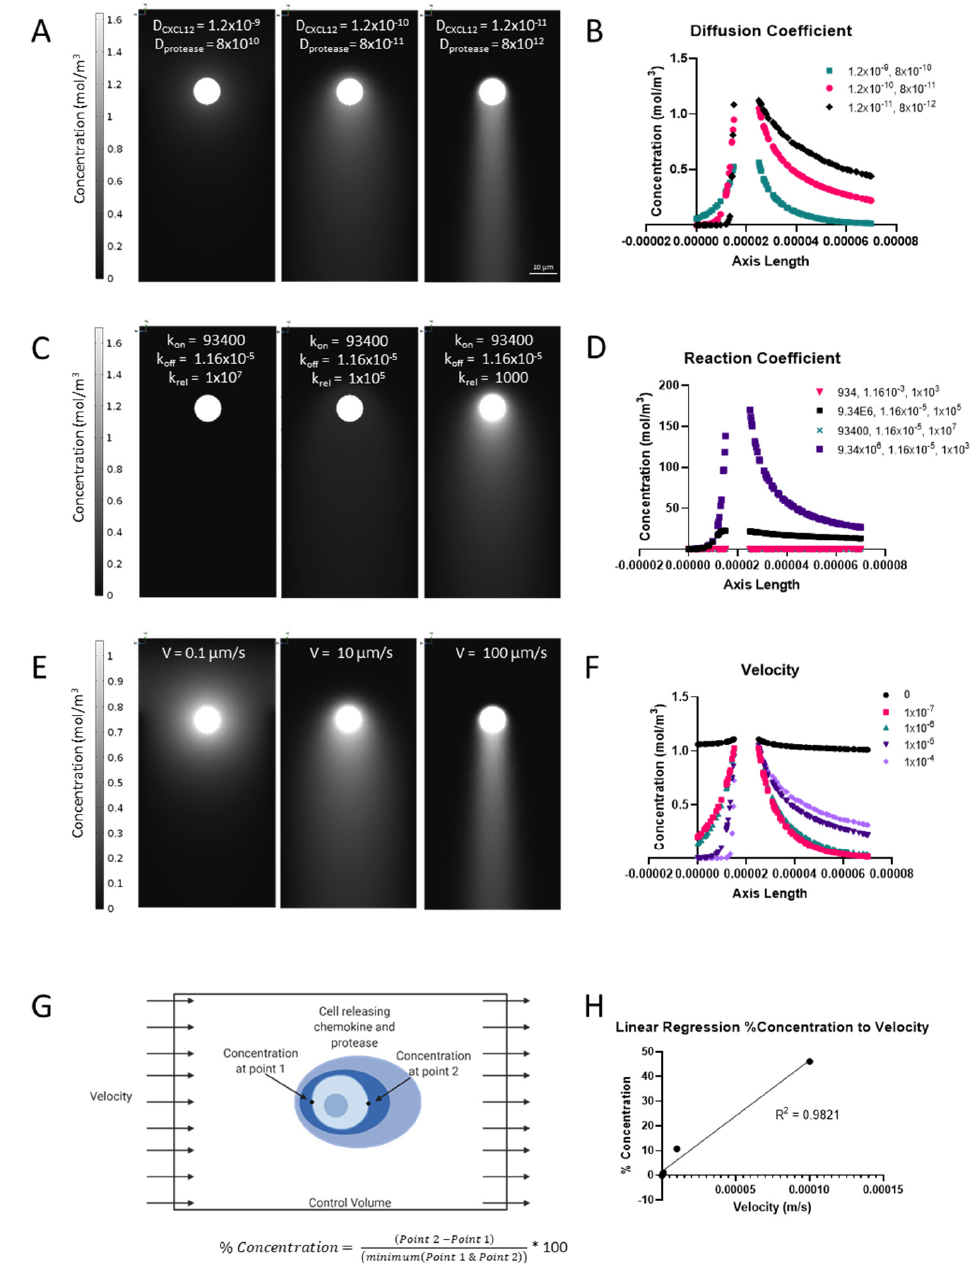
Figure 1. Modulation of transport parameters yields expected responses in gradient formation. ( A ) Representative images of three different diffusion coefficient combinations which create varying bound CXCL12 gradients around the cell. ( B ) Quantification of % concentration (bound CXCL12) around the cell. ( C ) Representative images of three combinations of reaction coefficients showing the differential response of gradient formation. ( D ) Quantification of bound CXCL12 around the cell with varying reaction coefficients. ( E ) Representative images of gradient formation with increasing velocity. ( F ) Quantification of % concentration at varying velocities. ( G ) Schematic of model and % concentration calculation. ( H ) Regression of relationship between % concentration and velocity, showing positive correlation between the two.